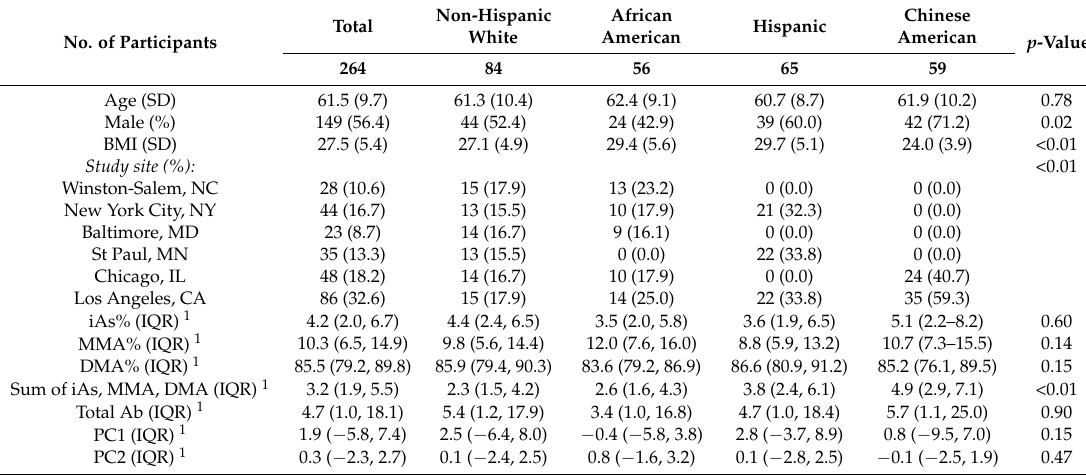
Table 1. Participant characteristics by